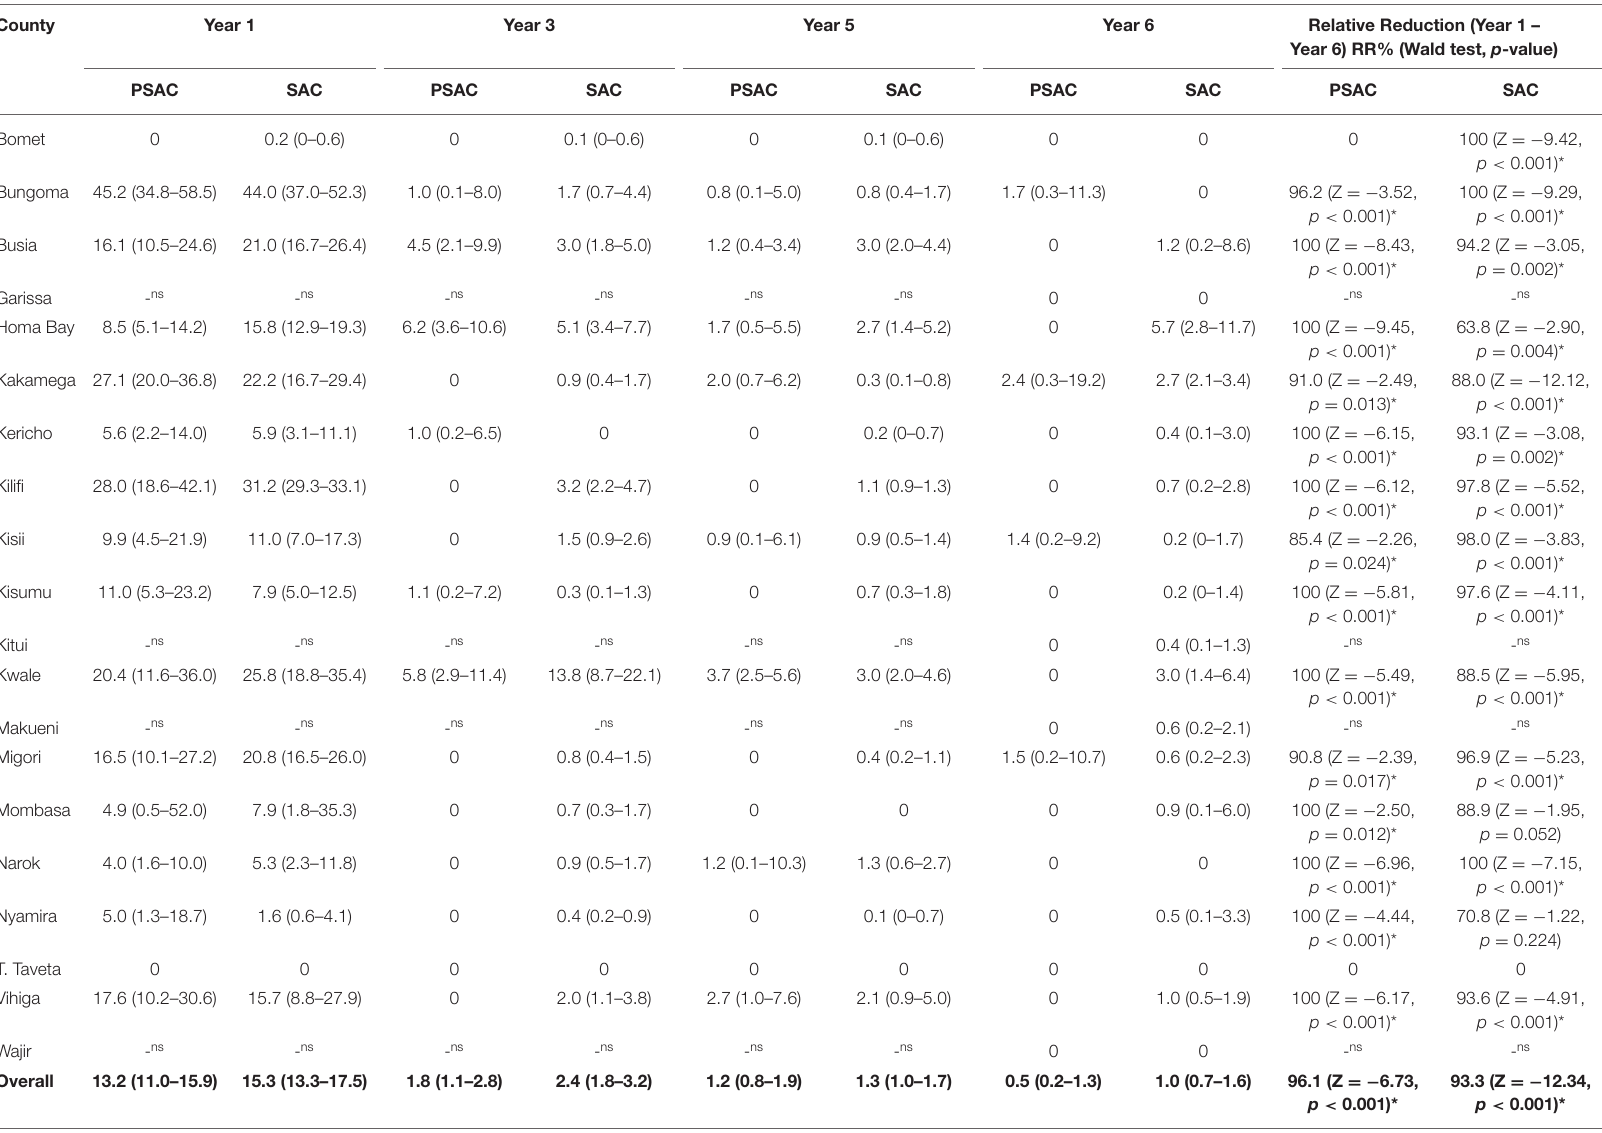
TABLE 5 | Preschool (PSAC) and school (SAC) aged pre-treatment prevalence % (95%CI) and relative reductions % (Wald test: Z-statistic, p -value) for hookworm infection in 20 counties in